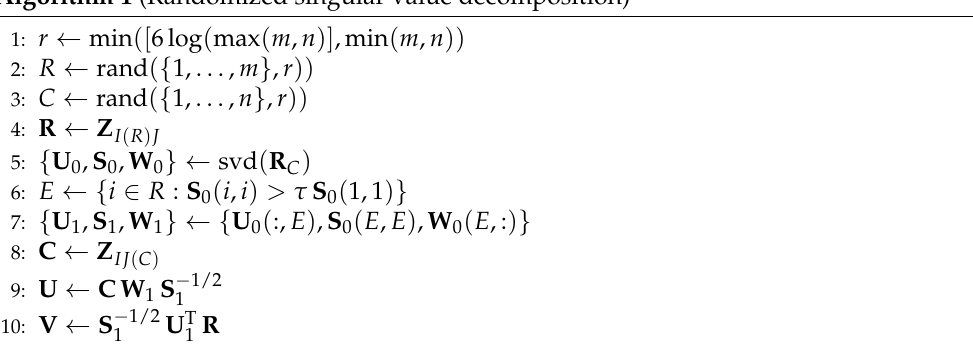
Algorithm 1 (Randomized singular value